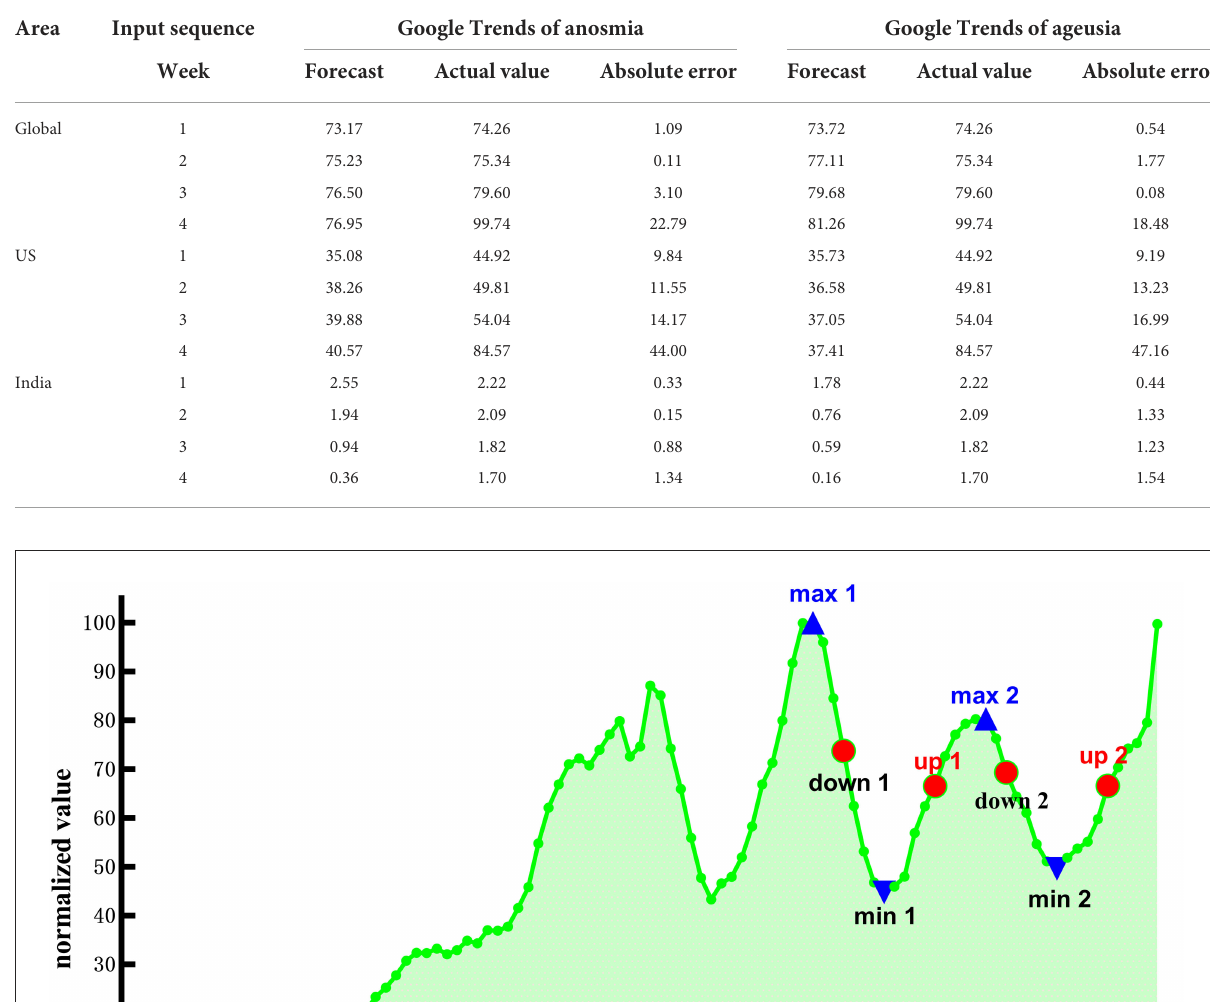
TABLE 4 Absolute error between forecast values and actual values for the following 4 weeks.